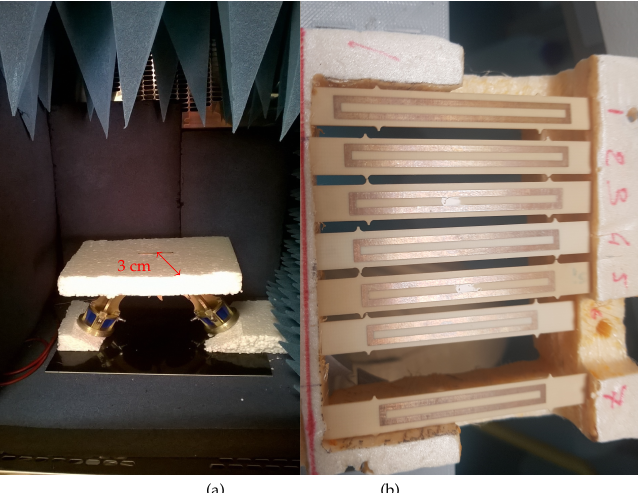
Figure 9. Photo of the measurement bench and tags. ( a ) Setup inside the climatic chamber. ( b ) Copper loop resonators on Rogers RO4003C substrates used for the measurements. Resonances frequencies were 2.013, 2.121, 2.218, 2.287, 2.430 and 2.558